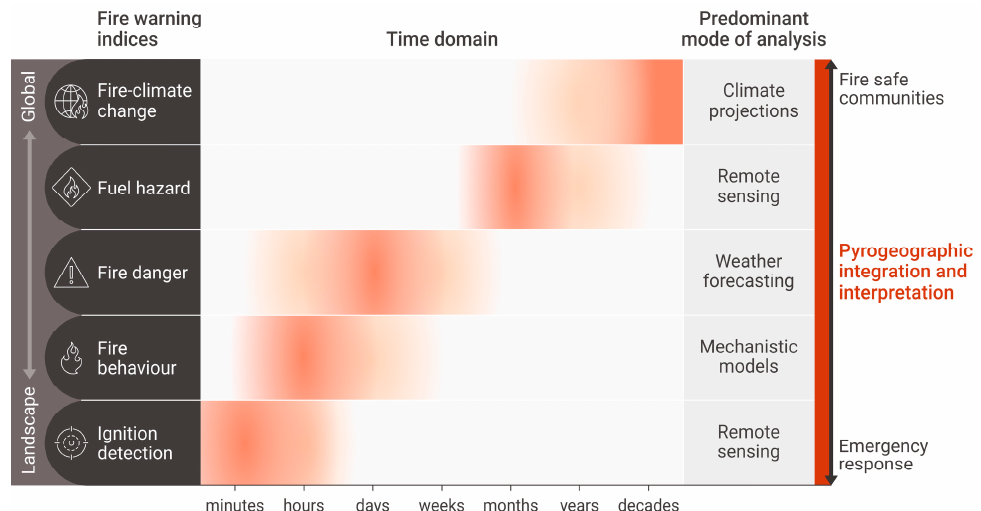
Figure 1. Conceptual model of the spaciotemporal domains of detecting, monitoring and foreseeing wildland fire. There is a spectrum from place-based detection, monitoring and prediction of wildland fires, which is essential for firefighting, to a more geographically broad-scale assessment of likely future fuel hazards and fire-climate change that assists community and national planning and adaptation to landscape fires. Expert integration, interpretation and public communication of these different streams are essential for effective emergency responses and fire management.